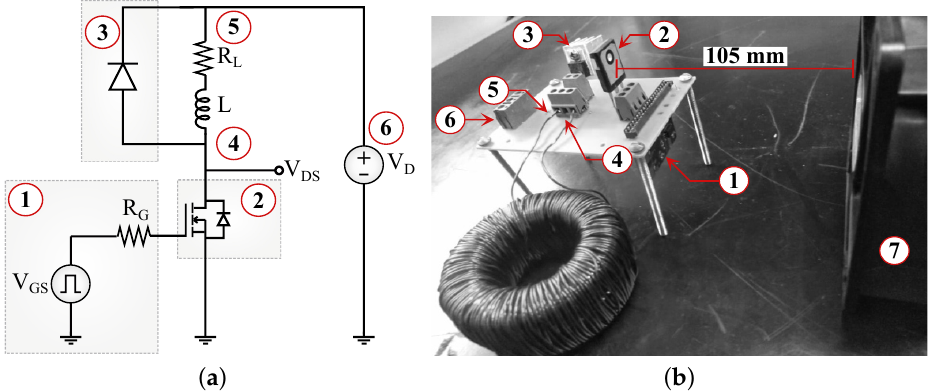
Figure 1. Test circuit: ( a ) diagram and ( b ) experimental setup; (1) Gate driver; (2) Device under test; (3) Diode with heat sink; (4) Inductor; (5) Resistive load (bottom side); (6) Adjustable voltage source V D used to maintain V DS constant; (7) Air